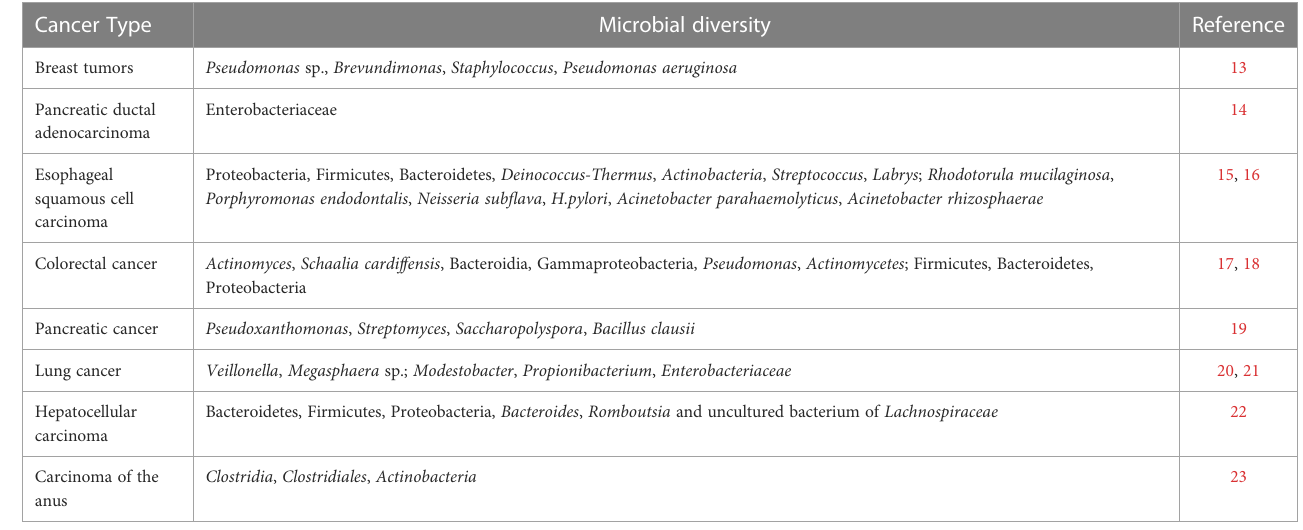
TABLE 1 Statistical table of microbial diversity of different tumor